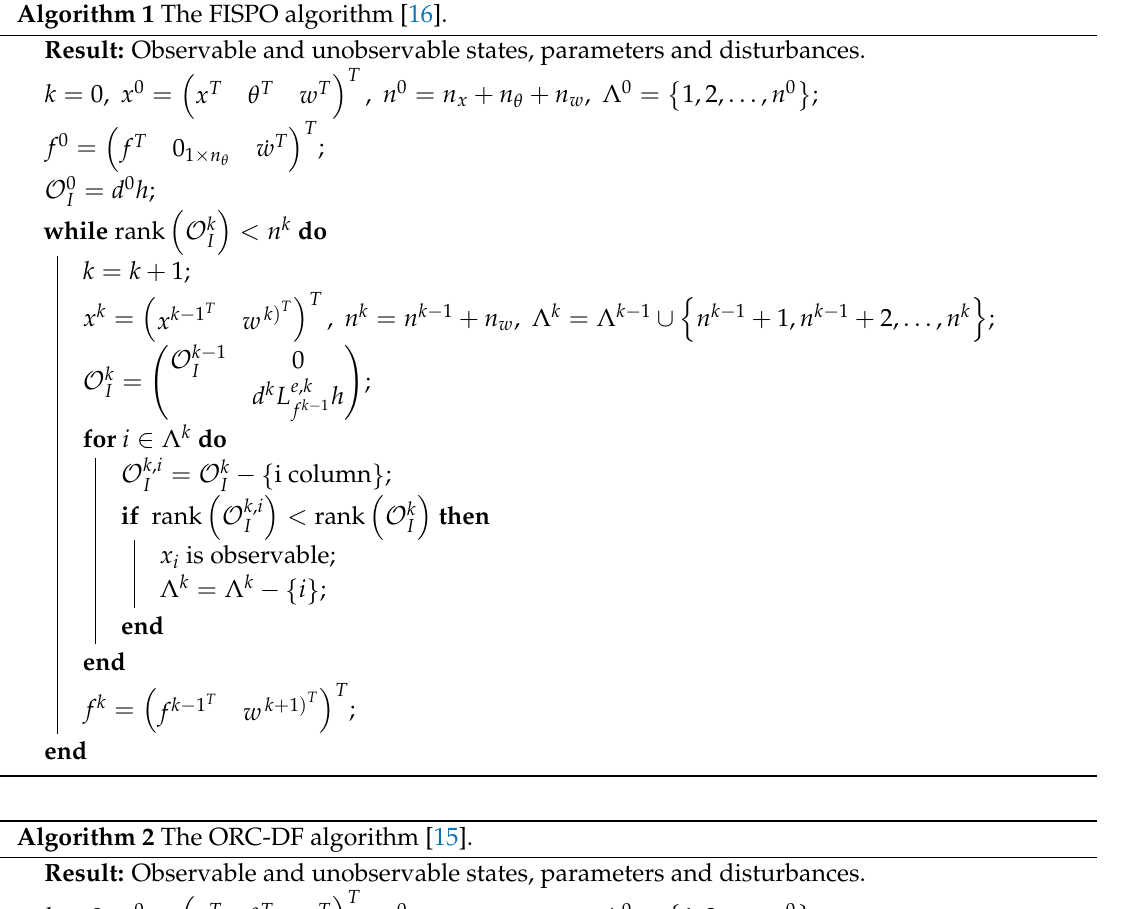
Algorithm 2 The ORC-DF algorithm